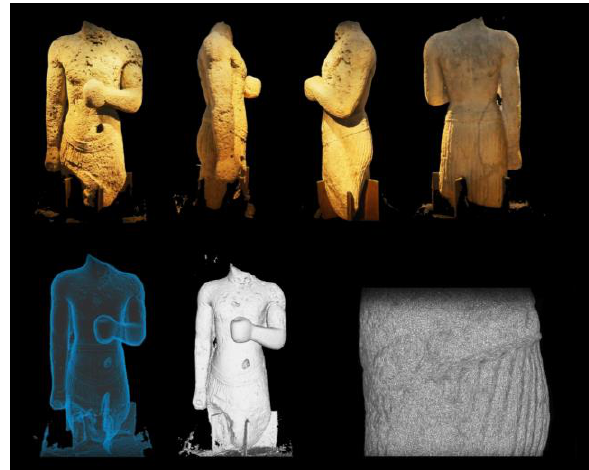
Figure 15. Bust Sculpture 3D model